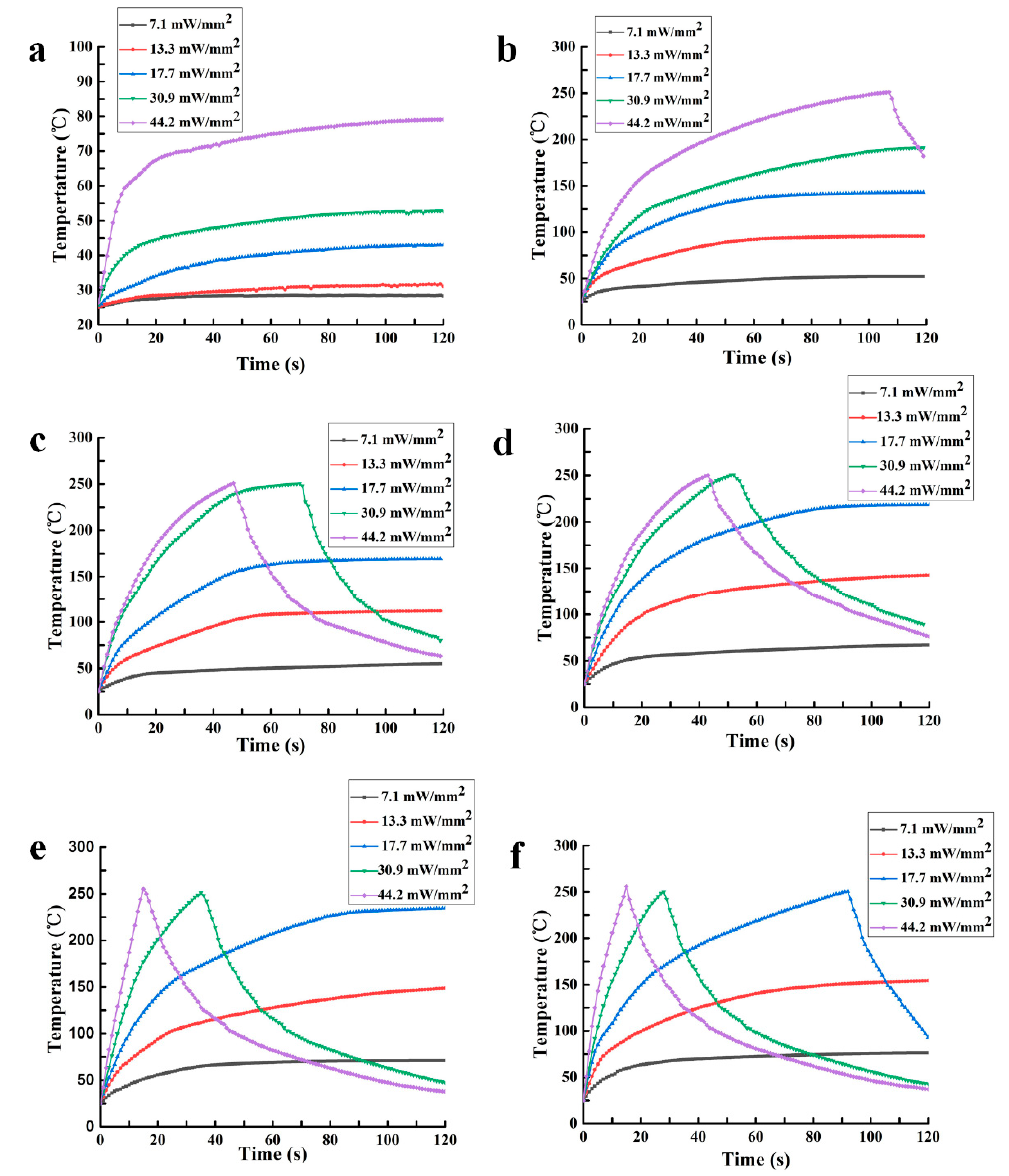
Figure 5. Temperature curves of the sample films under different radiation intensities. ( a ) Blank PDMS films without AuNPs. ( b ) Sample film A—0.031% AuNPs. ( c ) Sample film B—0.062% AuNPs. ( d ) Sample film C—0.093% AuNPs. ( e ) Sample film D—0.124% AuNPs. ( f ) Sample film E—0.155% AuNPs.